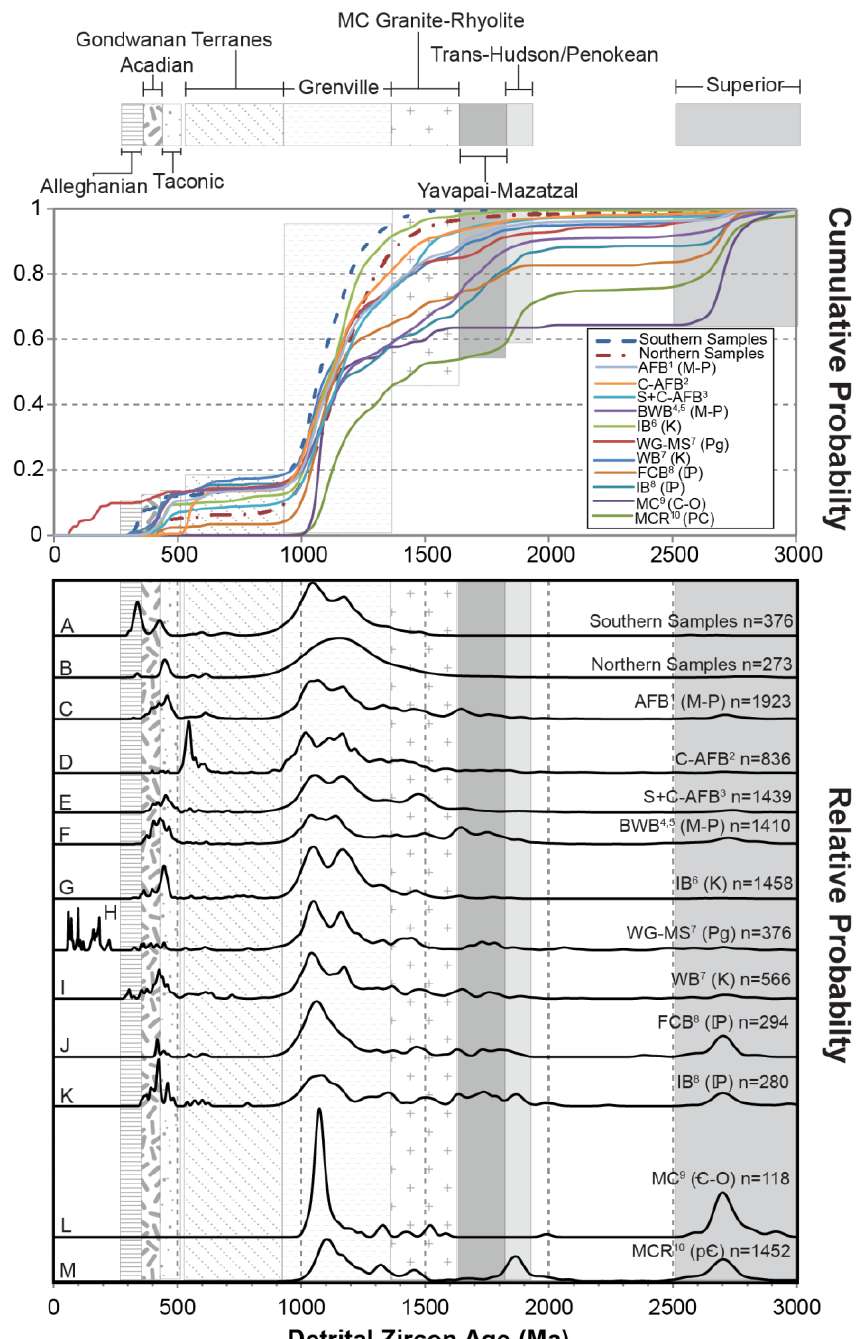
(B) NS, (C) Ordovician and Devonian strata in the Appalachian Foreland Basin (AFB); 1 [50]), (D) Cenomanian – Albian Dakota Fm from the FCB; 2 [17]), (E) Paleocene Wilcox Group strata from Tennessee (WG – TN); 3 [1], (F) Cenomanian Tuscaloosa Sandstone (TS). Potential source regions are shown as vertical bars. Samples shown have K – S statistical p-values > 0.05 when compared to either the SS or NS.